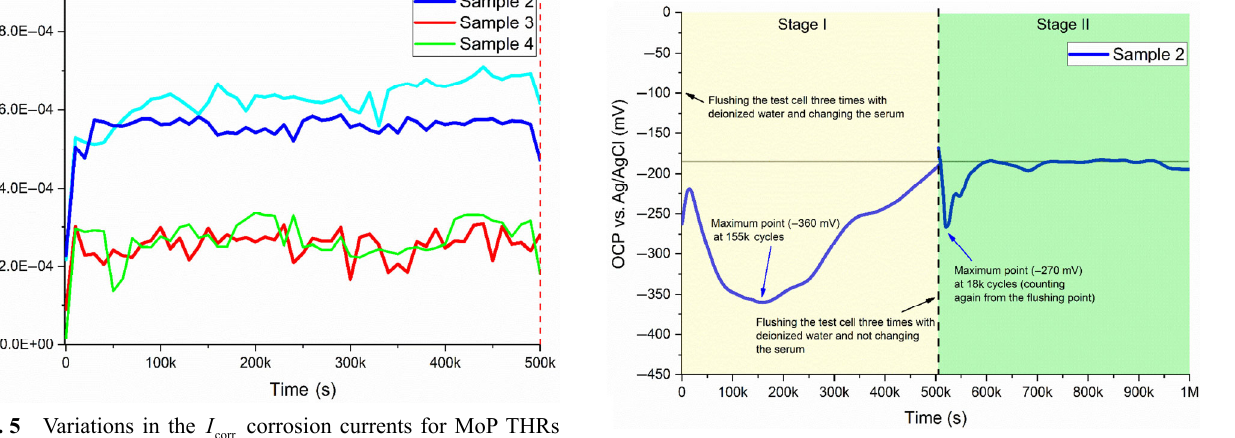
Fig. 6 Variation in OCP for a change (Stage I, Sample 2) and no change (Stage II, Sample 2) in the serum